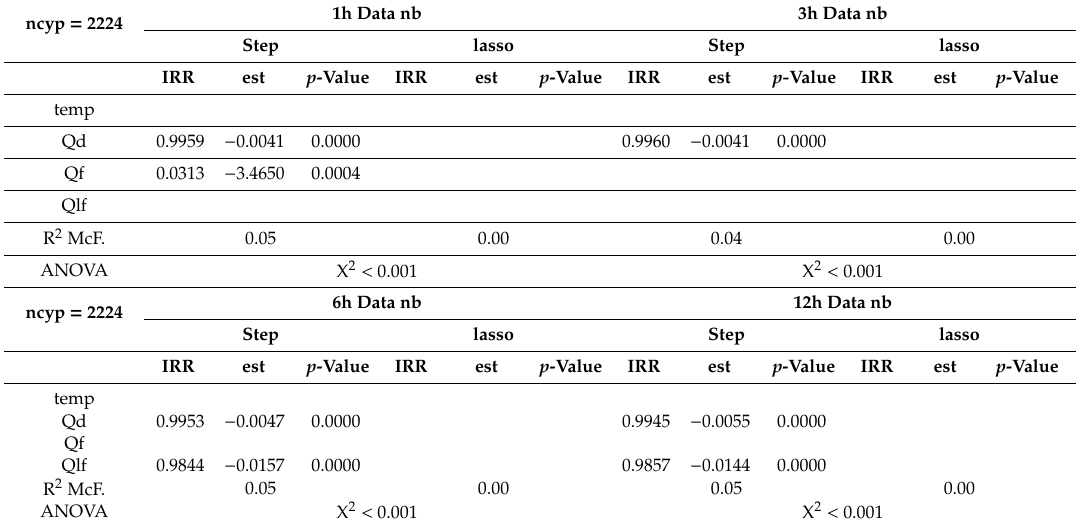
Table 8. Results of variable selection of all cyprinids without A. alburnus